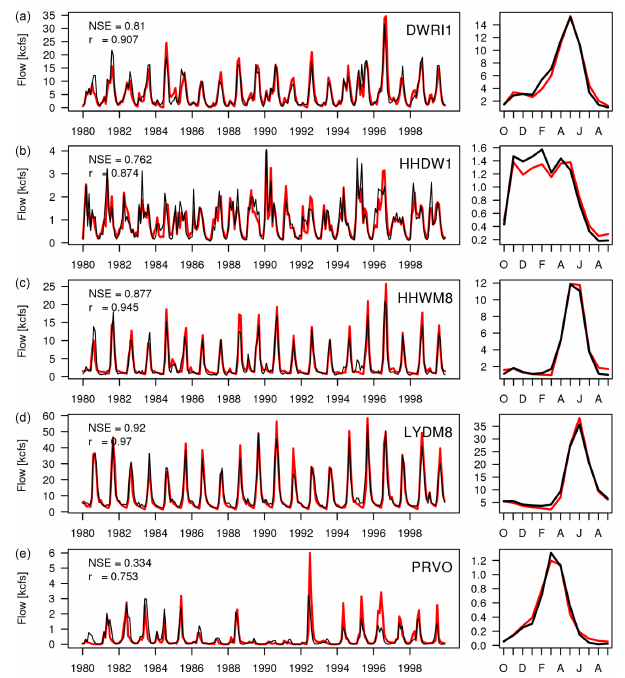
Figure 4. Monthly streamflow simulations (red) and observations (black) for the period October 1980–September 2000. Left panels display monthly time series, with NSE and r denoting the Nash– Sutcliffe efficiency and correlation, respectively. Right panels show simulated and observed seasonal streamflow cycles. Results are displayed in kilo cubic feet per second (kcfs) – where 1kcfs is equivalent to 28.32m 3 s − 1 – for (a) Dworshak Reservoir inflow (DWRI1), (b) Howard Hanson reservoir inflow (HHDW1), (c) Hun- gry Horse reservoir inflow (HHWM8), (d) Libby dam inflow (LYDM8), and (e) Prineville reservoir inflows (PRVO).